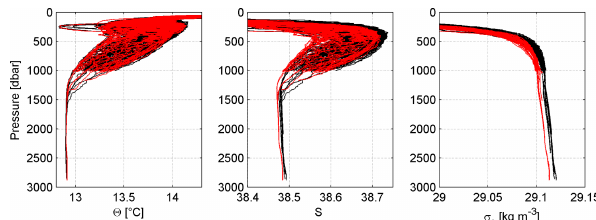
Figure 2. Potential temperature ( (cid:50)) , salinity ( S ), and potential den- sity anomaly ( σ (cid:50) ) profiles of Sea-Bird CTD casts obtained by Planet (black) and Alliance (red) with a focus on the lower water column.